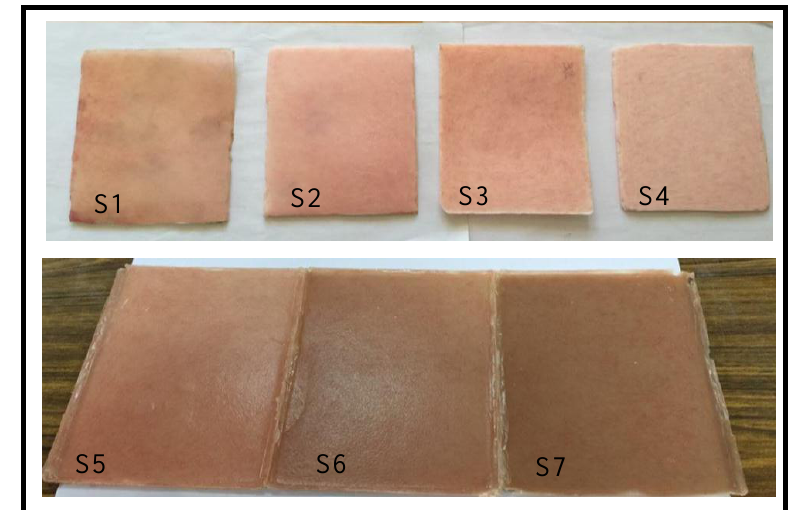
O ) and (Peanuts 2 3